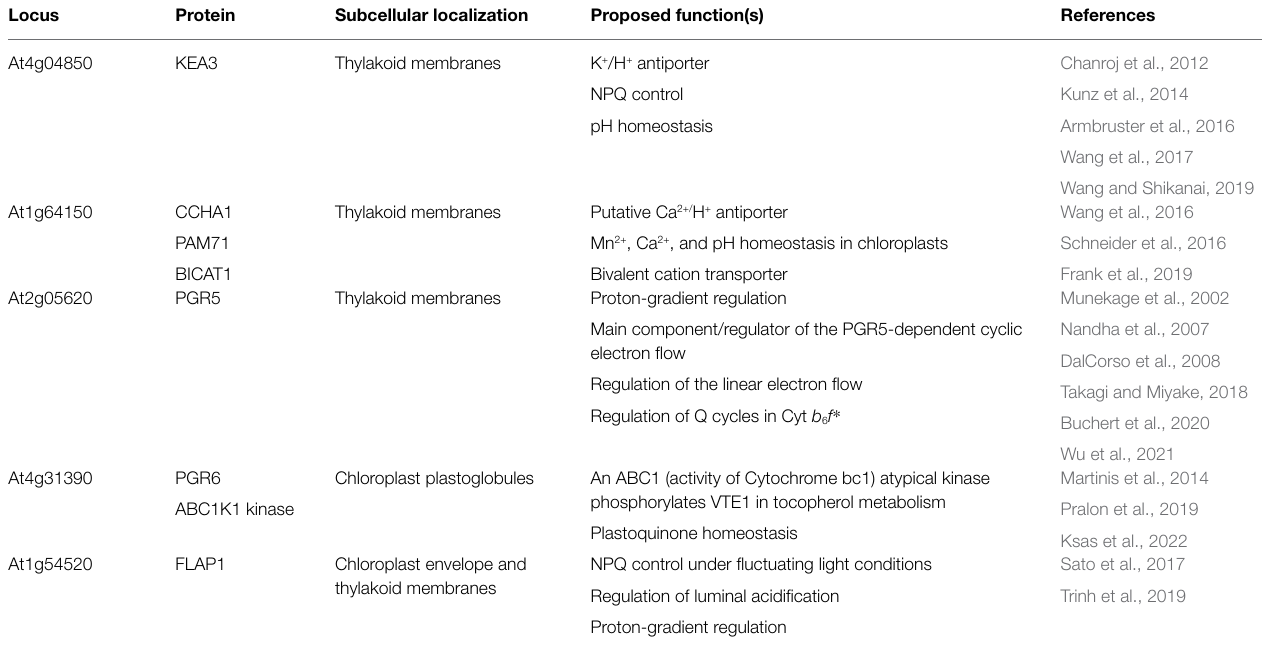
TABLE 1 | Proton-involved transporters and protein factors regulate thylakoid luminal pH. Locus